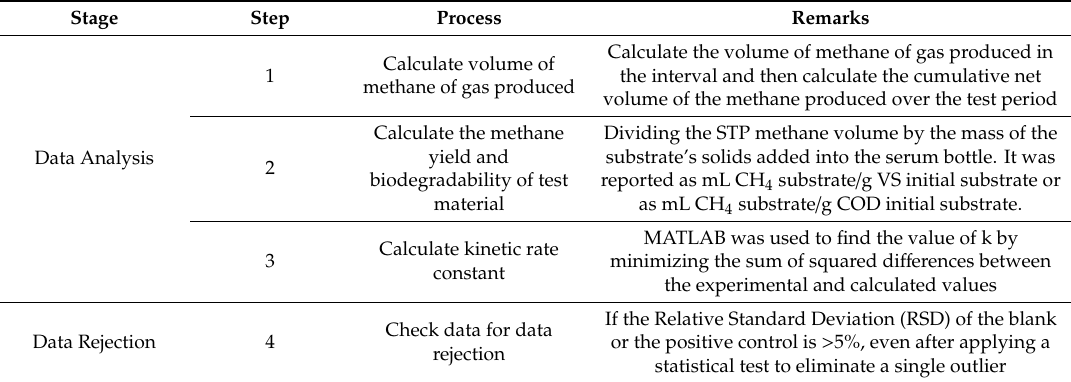
Table 7. Data analysis stages and steps for